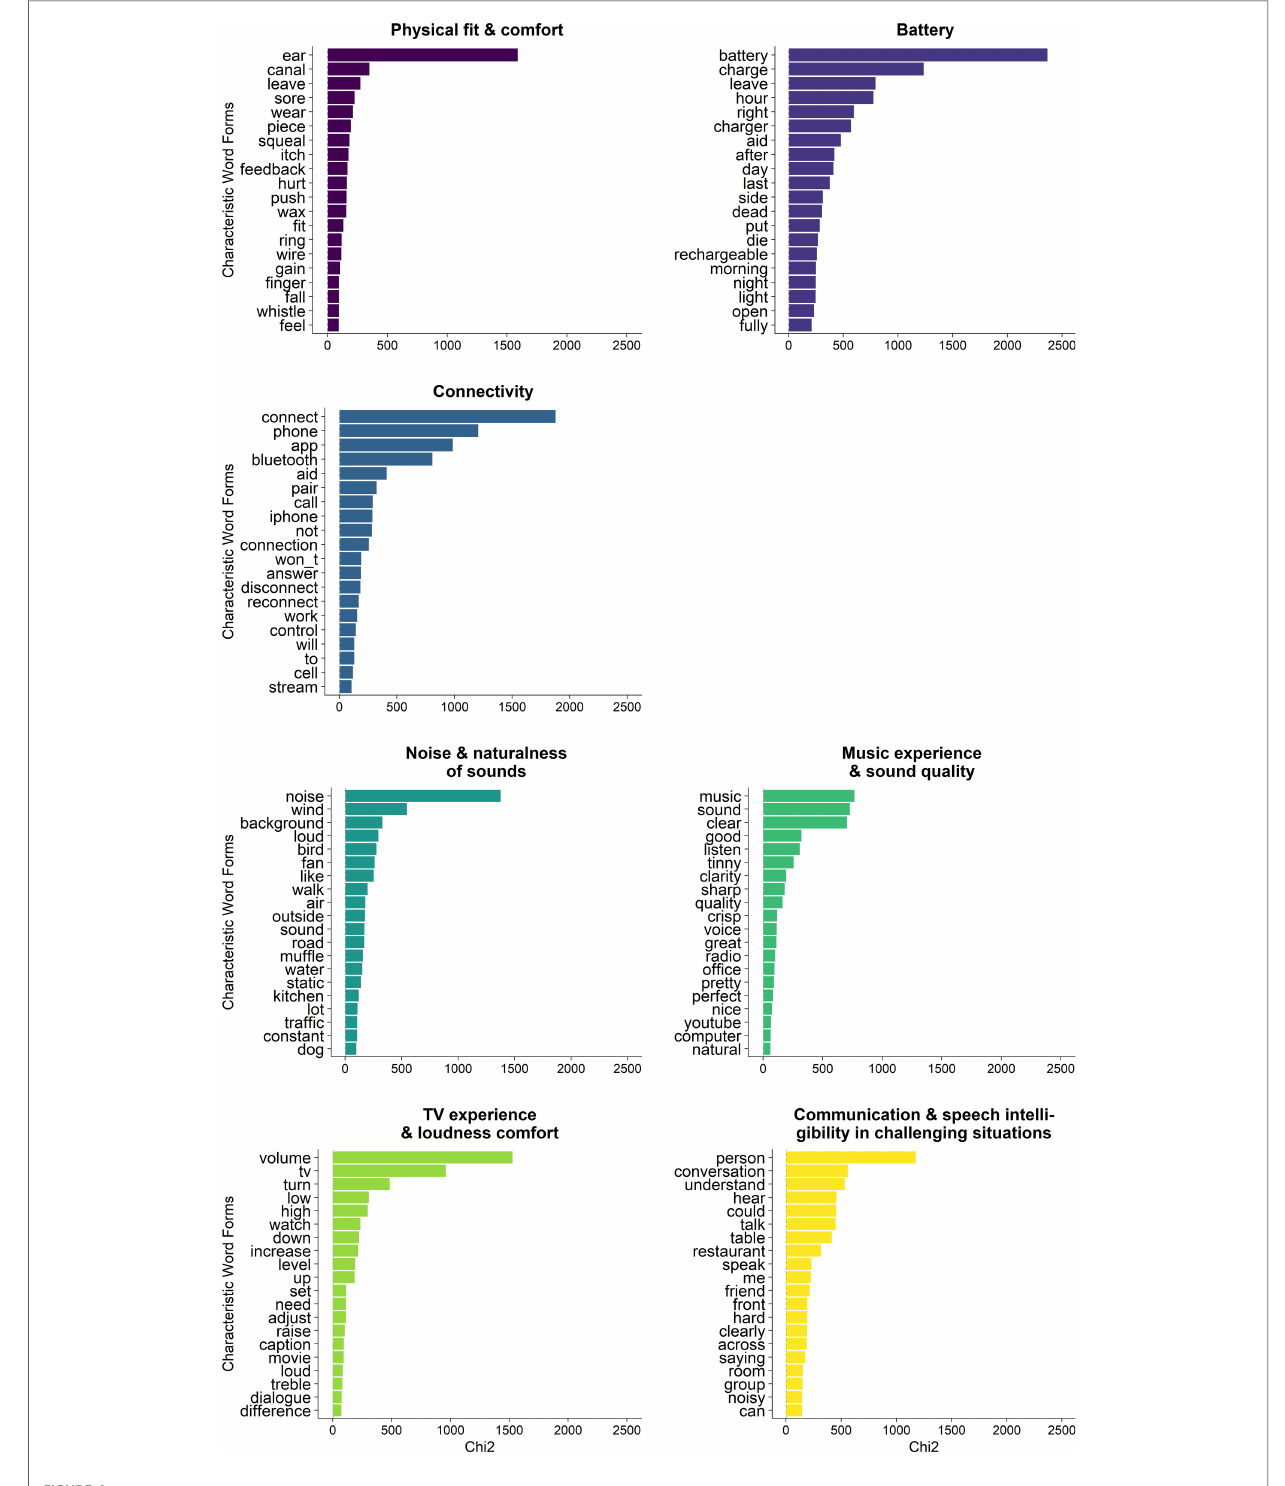
FIGURE 4 Graphical overview of the top twenty characteristic words for each cluster ( y -axis), ranked from highest to lowest χ 2 -value ( x